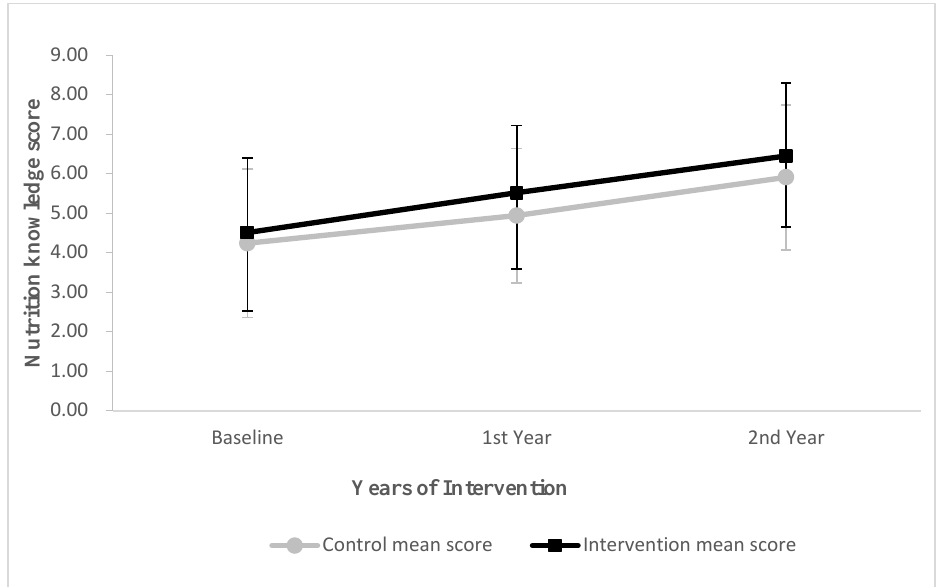
Figure 2. Changes in mean score for children’s nutrition knowledge in first and second year from baseline. Vertical bars indicate standard deviations. Table 4. Test of the fixed effects of various factors of nutrition knowledge score.